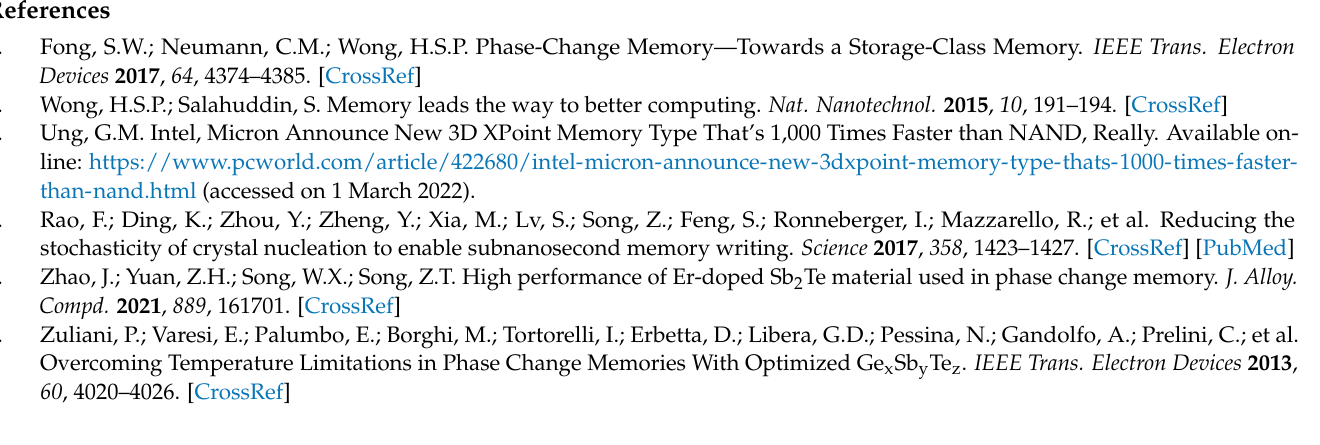
C doping contents and C existing forms; Figure S2: The pair correlation function after structure relaxation; Figure S3: XRD diagram of C 40W Sb 2 Te 3 at 225 ◦ C; Figure S4: The optical image of the fabricated PCRAM cells; Figure S5: I-V curve of PCRAM unit set from high resistance state to low resistance state by DC current; Figure S6: SET the PCRAM in a low resistance state with a large/small set pulse, and then RESET it with a 500 ns pulse to obtain a continuously adjustable resistance